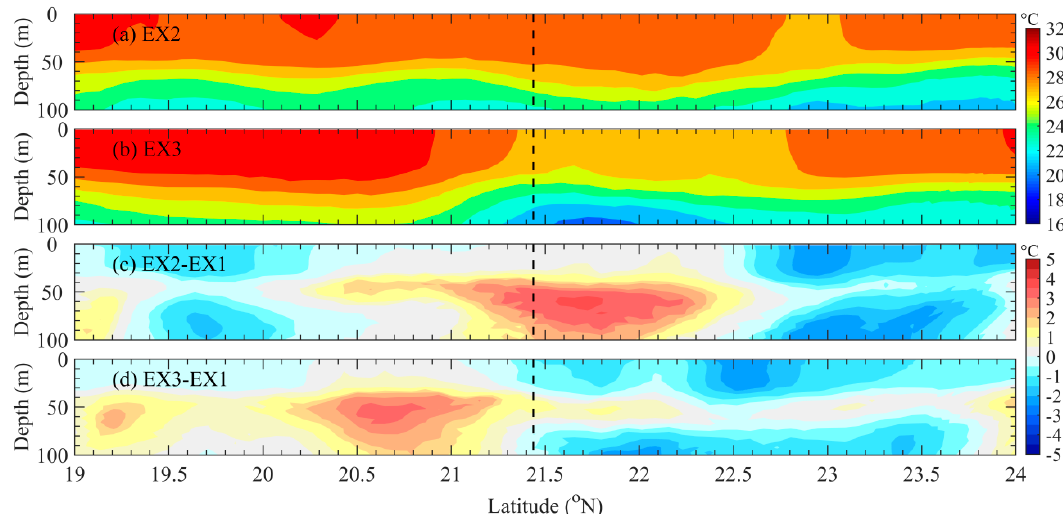
Figure 11. Profiles perpendicular to the track on 8 July 2016. Modeled temperature results for (a) EX2 and (b) EX3. The temperature difference between (c) EX2 and EX1, and between (d) EX3 and EX1. The black dashed line indicates the track position.